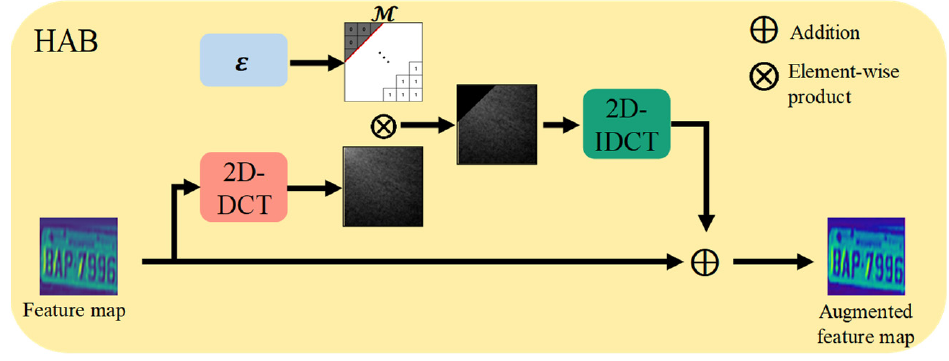
Figure 5. Architecture of HAB.